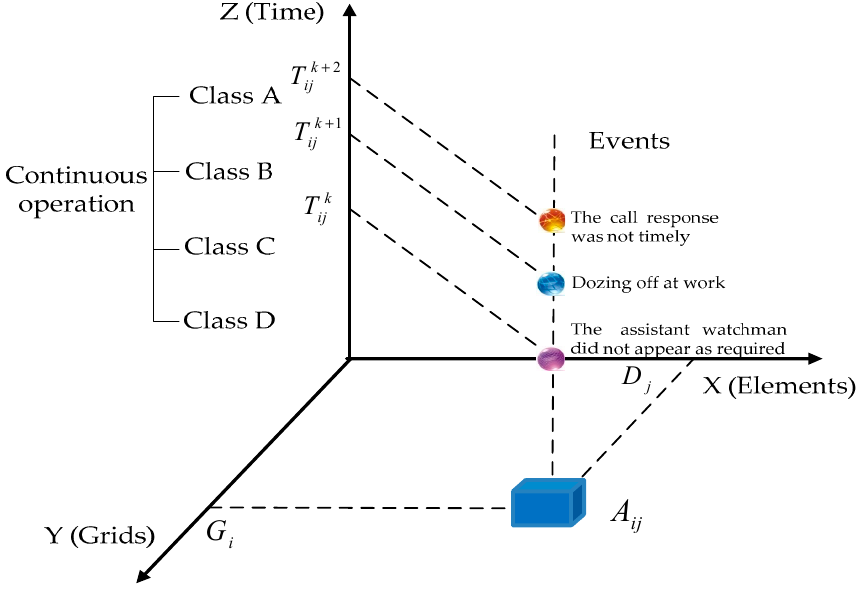
Figure 1. Grid, element and event interrelation.